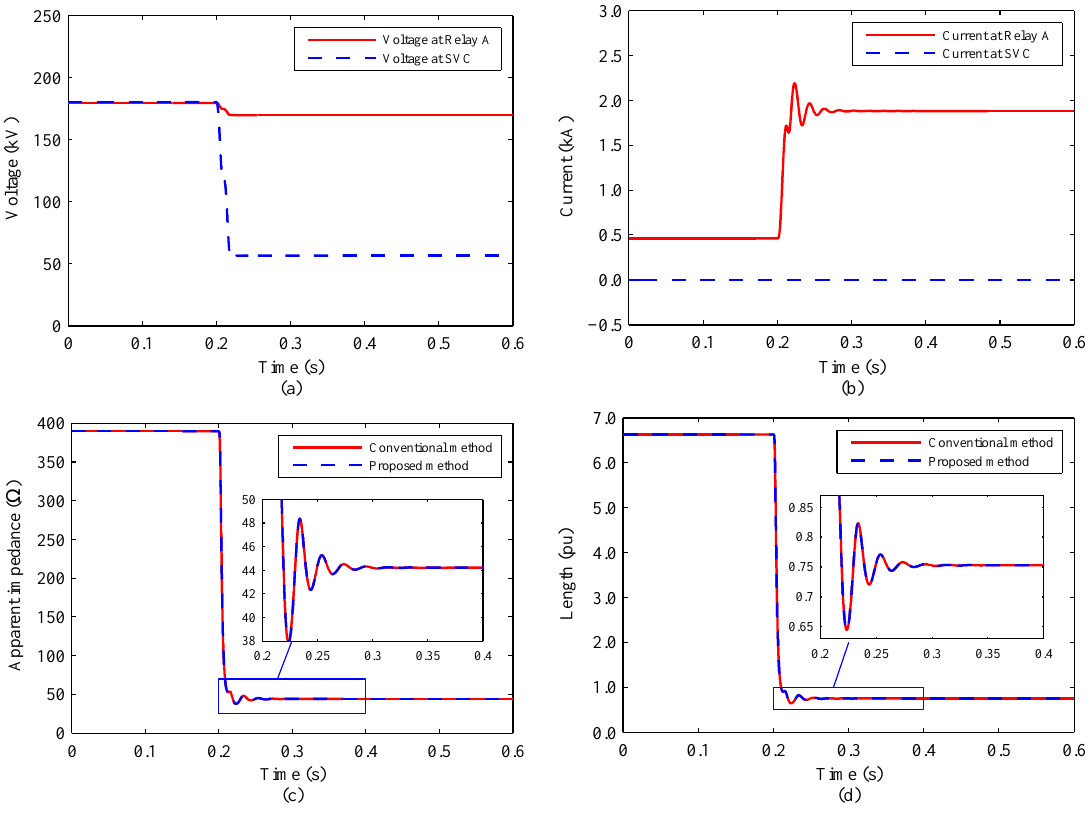
Figure 6. The simulation results of Case 1. ( a ) voltage measurement; ( b ) current measurement; ( c ) apparent impedance at relay A; ( d ) fault